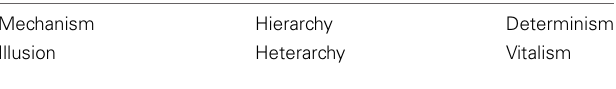
Table 1 | Dichotomies on the notion of